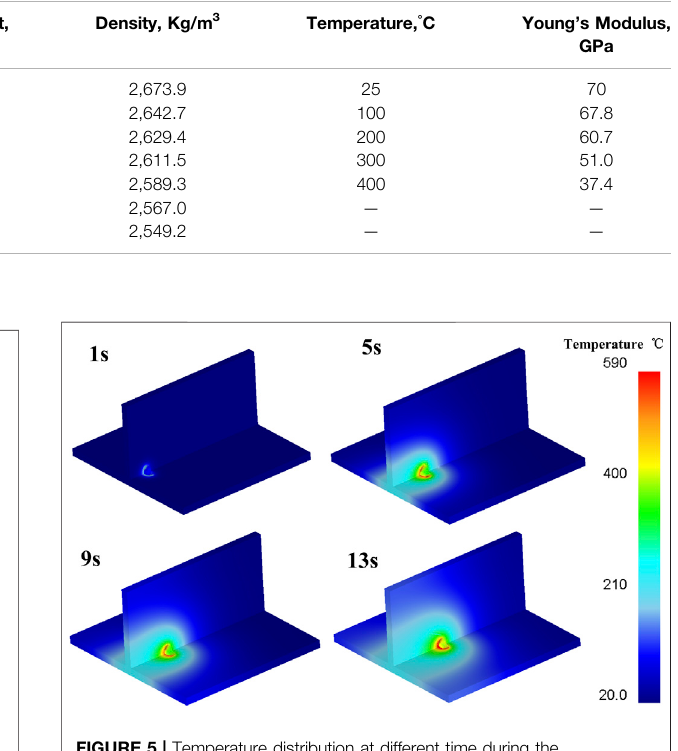
TABLE 3 | Thermal properties of 5,083 aluminum at different temprature.